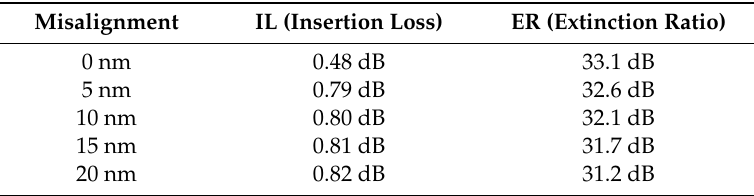
Table 1. ON-state insertion loss and ON-OFF switching extinction ratio for different lateral alignment errors between the GST and Si waveguides.